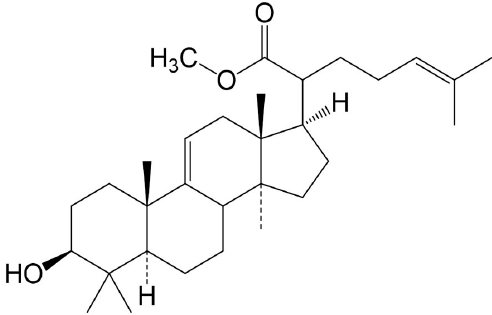
Figure 1. The chemical structure of methyl-3 β -hydroxylanosta-9,24-dien-21-oate (RA-3).